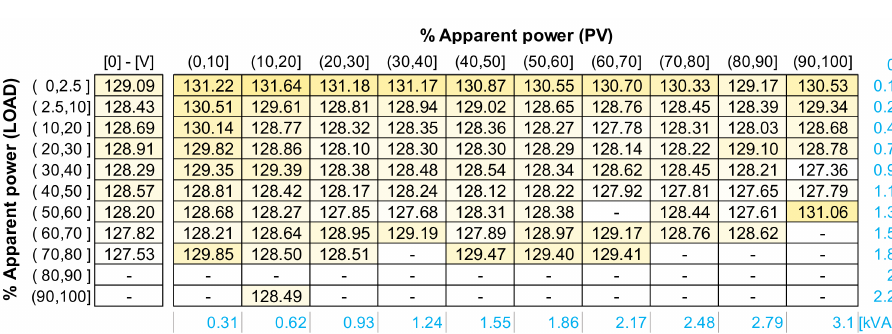
Figure 15. Matrix of average values of Vrms for each scenario of Phase B.